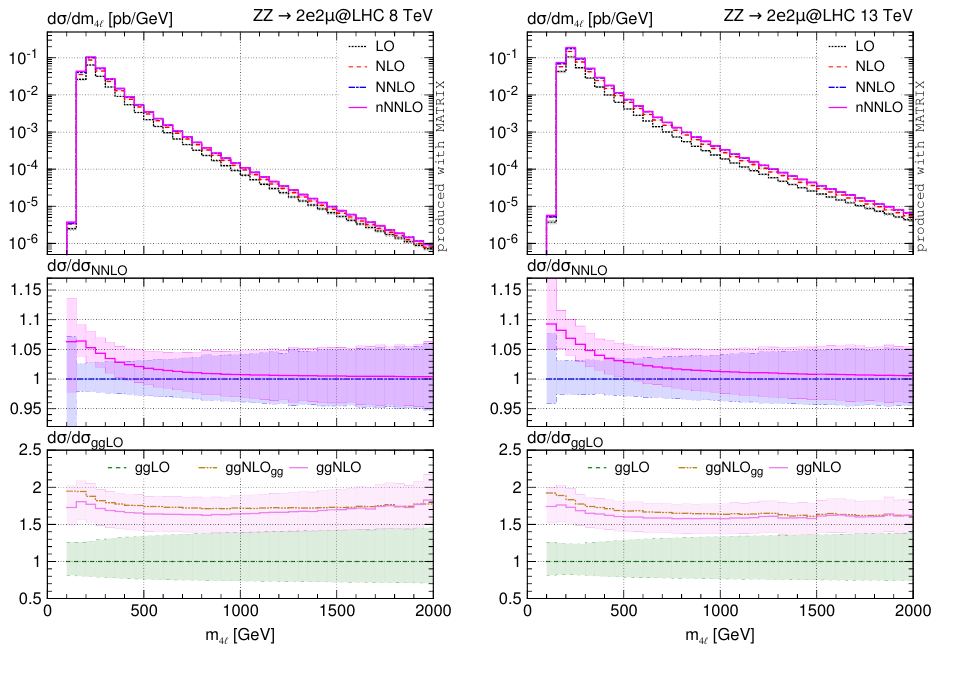
Figure 4 . Di(cid:11)erential distribution in m